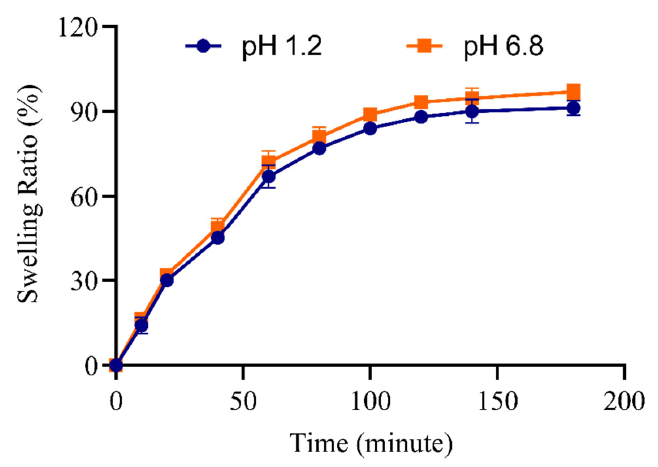
Figure 2. pH effect on % equilibrium swelling (CDN5) (Mean ± SD, n = 5).